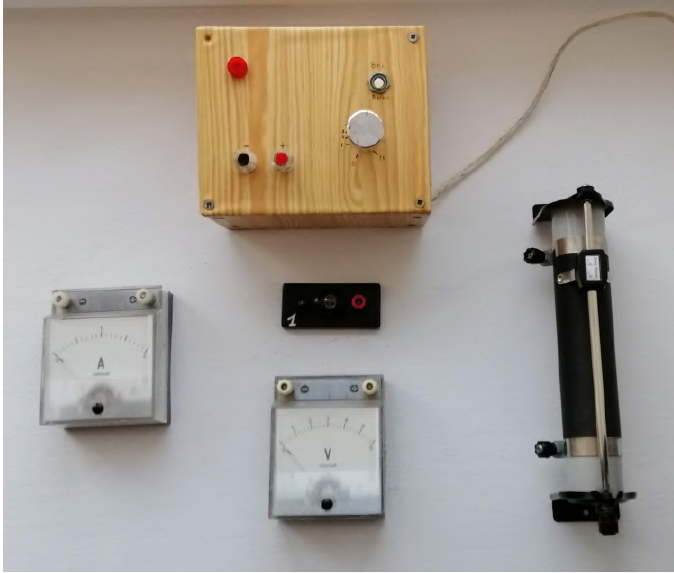
Figure 1: 3D physical models in teaching physics to study the electric